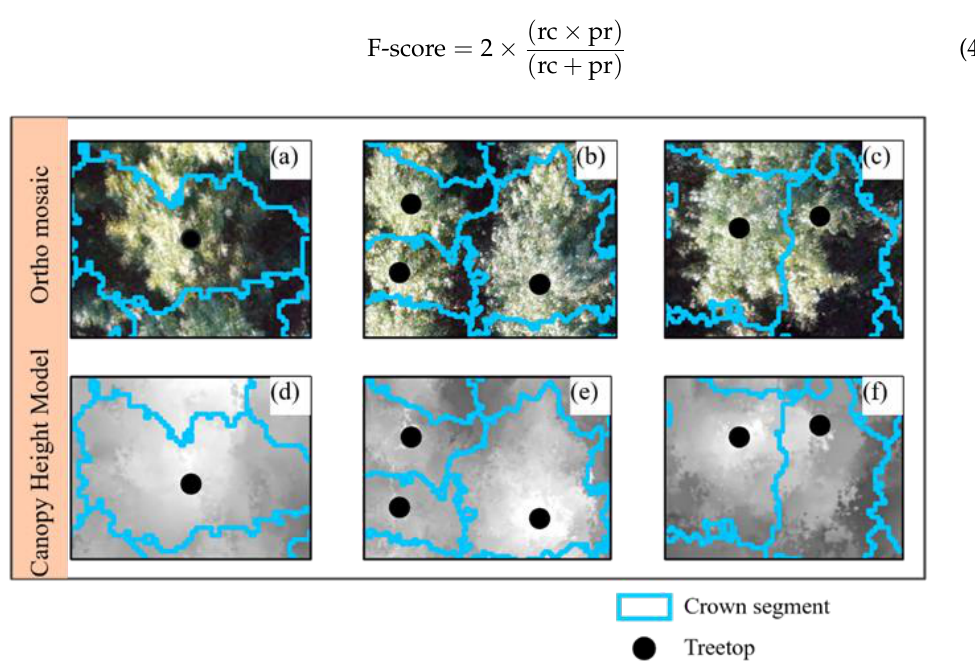
Figure 3. Illustration of issues involved in treetop detection and crown segmentation of individual trees performed using the automated technique proposed in this study. Panels ( a , d ) represent perfect segmentation. Panels ( b , e ) represent undersegmentation. Panels ( c , f ) represent oversegmentation with orthophoto and